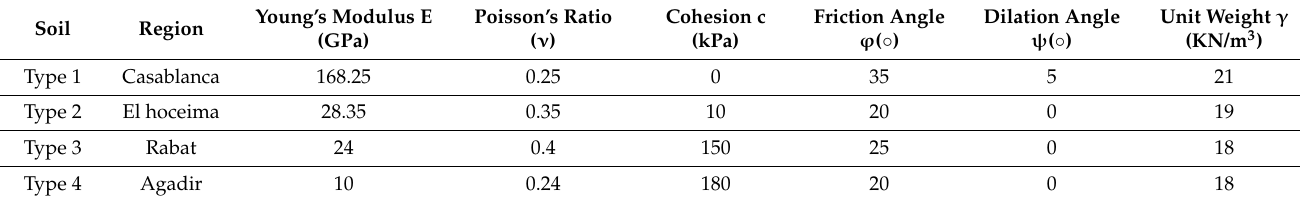
Table 1. Geotechnical